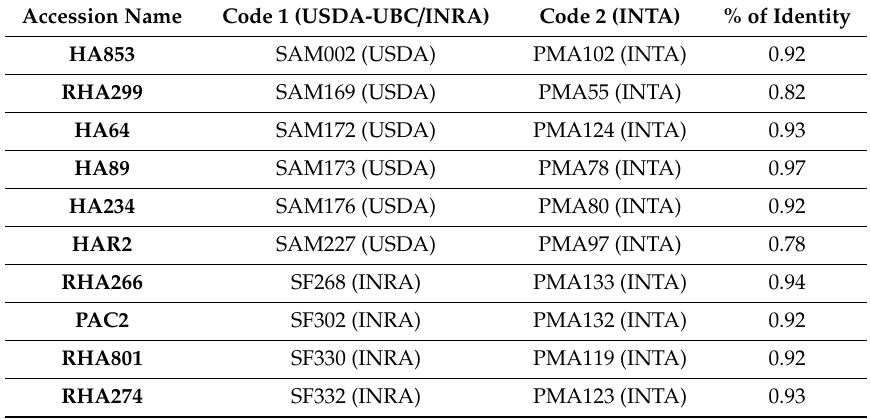
Table 2. Percentage of identity between public sunflower inbred lines present in more than one breeding